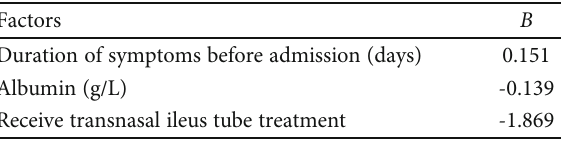
Table 5: Logistics analysis of factors of patients ’ transition to